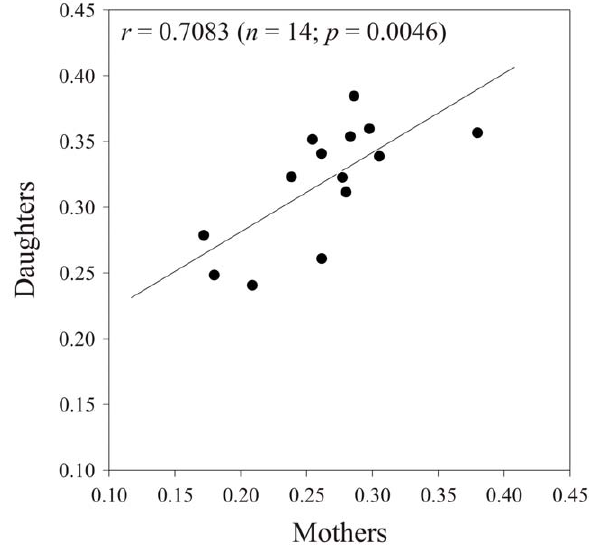
Figure 2. Mother-daughter regression analysis of the Re- productive Concentration Index (RCI) for Trichogrammabrassi- cae females. Values of the daughters are the averages of several offspring collected from each mother. The regression line and p -value are shown. The equation of the regression line is y=0.6025x + 0.1607. R 2 =0.502.